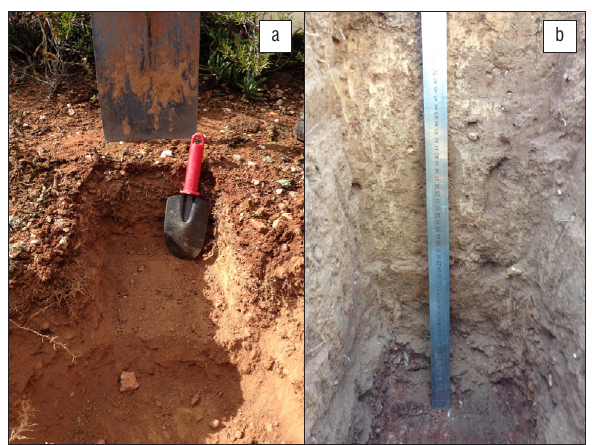
Figure 1: (a) A shallow pit off-mound with surface gravel including quartz that was used to indicate whether the mound was the product of erosion or accretion; (b) a soil pit in a mound with coarse gravel exposed in a side wall and a gravel accumulation visible above an indurate duripan at the base of the pit. Mound